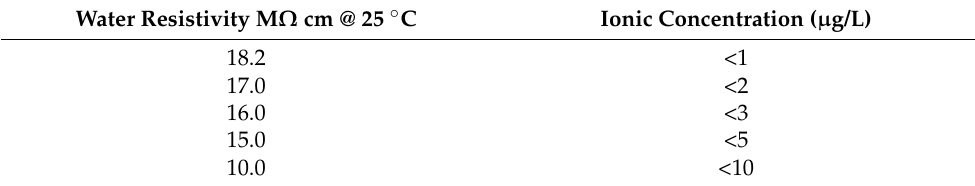
Table 1. Ultra-pure water quality (type 1)